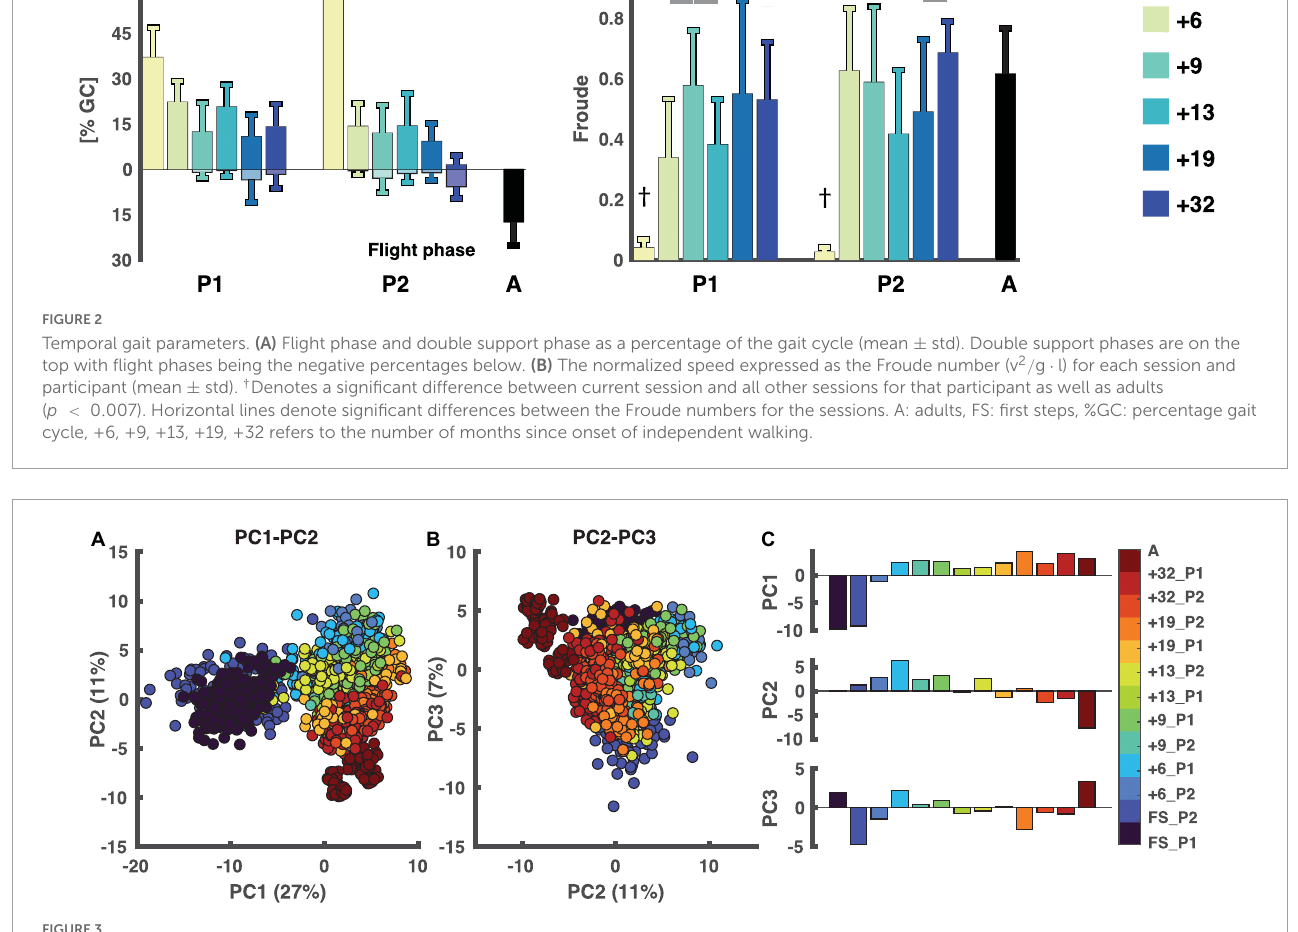
and 0.69 for the running sessions and three sessions of P1 (+6, +13, and +19, p < 2 × 10 − 9 ) and two sessions of P2 (+13 and +19, p < 2 × 10 − 7 ) were significantly different from the adults,